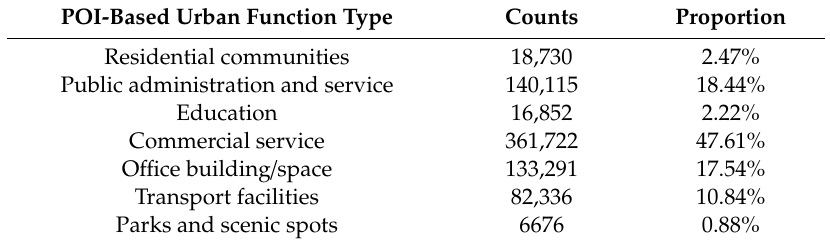
Table 1. Number of points-of-interest (POIs) in each urban functional category in